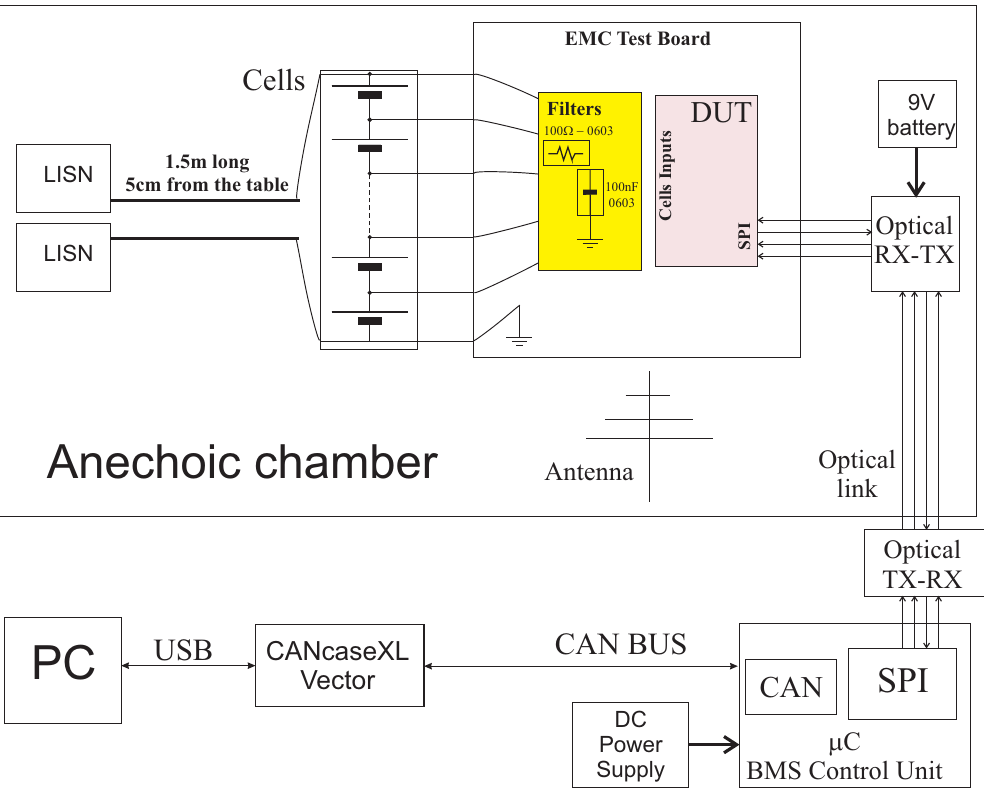
Figure 12. Radiated susceptibility test setup. Antenna in front of the equipment under test (EUT).